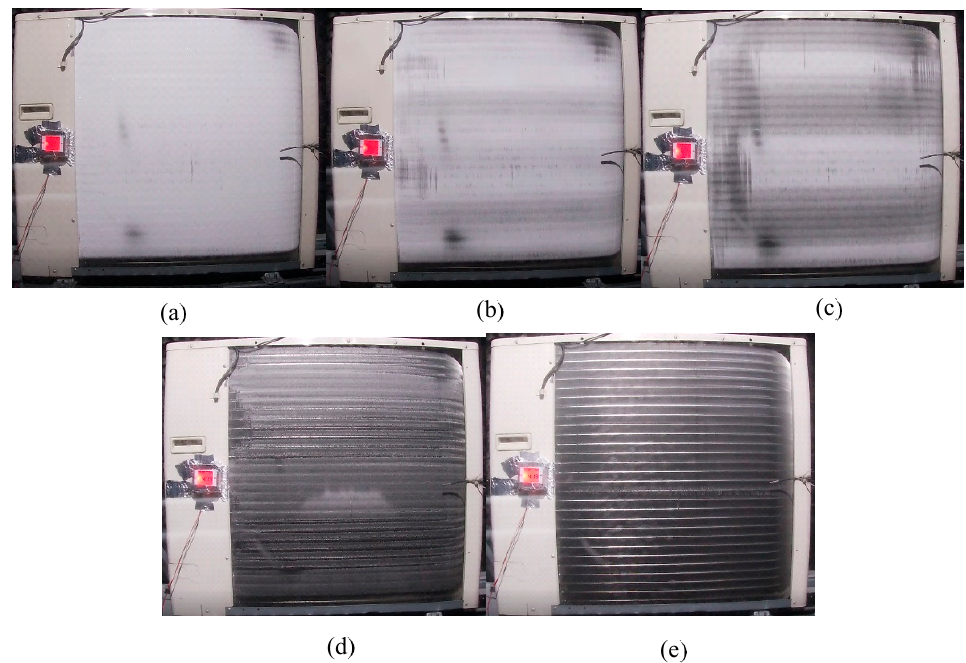
Figure 5. Defrosting the heat exchanger: ( a ) the first minute—the entire surface covered with frost; ( b ) the second minute— the start of the melting; ( c ) the third minute—frost melting; ( d ) the fourth minute—frost melting; ( e ) the fifth minute—condensate blowing.